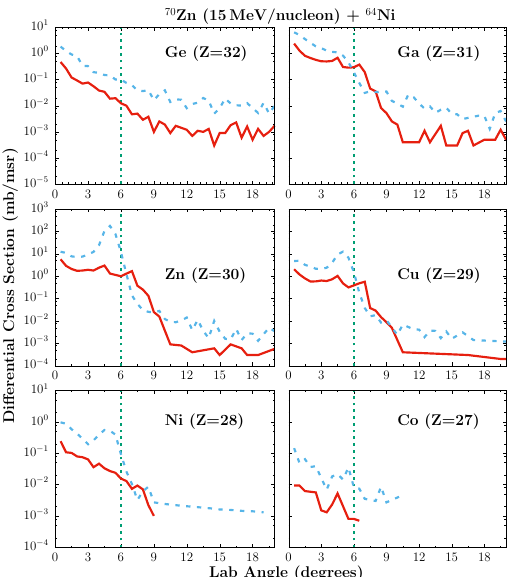
Figure 2. (Color online) Calculated elemental angular distributions of projectile fragments with Z = 27–32 from the reaction of 70 Zn (15 MeV / nucleon) with 64 Ni. The calculations shown are: DIT / GEMINI (solid red line), CoMD / GEMINI (dashed blue line). The green vertical line indicates the grazing angle for this reaction ( θ g r = 6 . 0 ◦